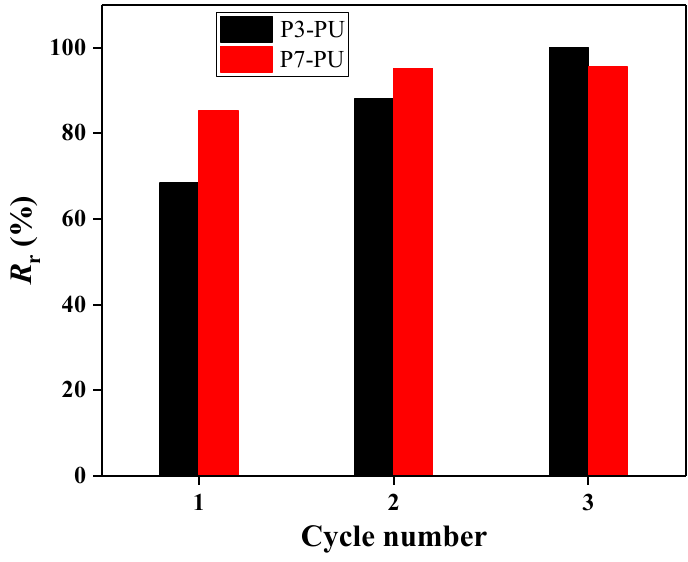
Figure 11. The strain recovery ratio ( R r ) during cyclic stretch.